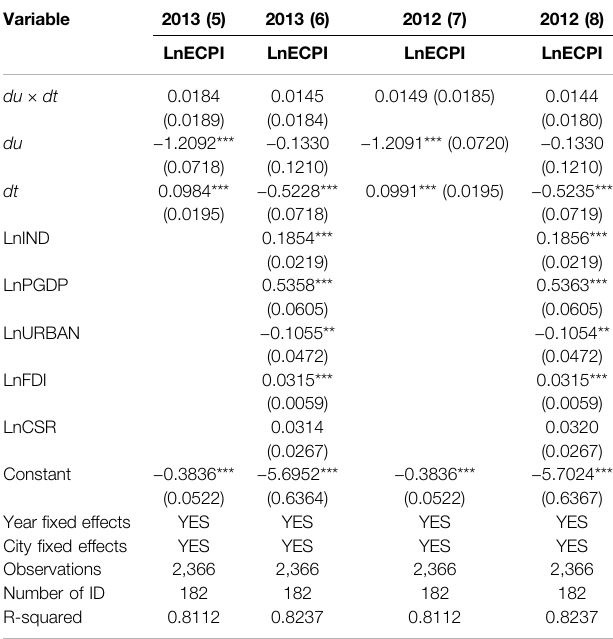
TABLE 4 | Counterfactual